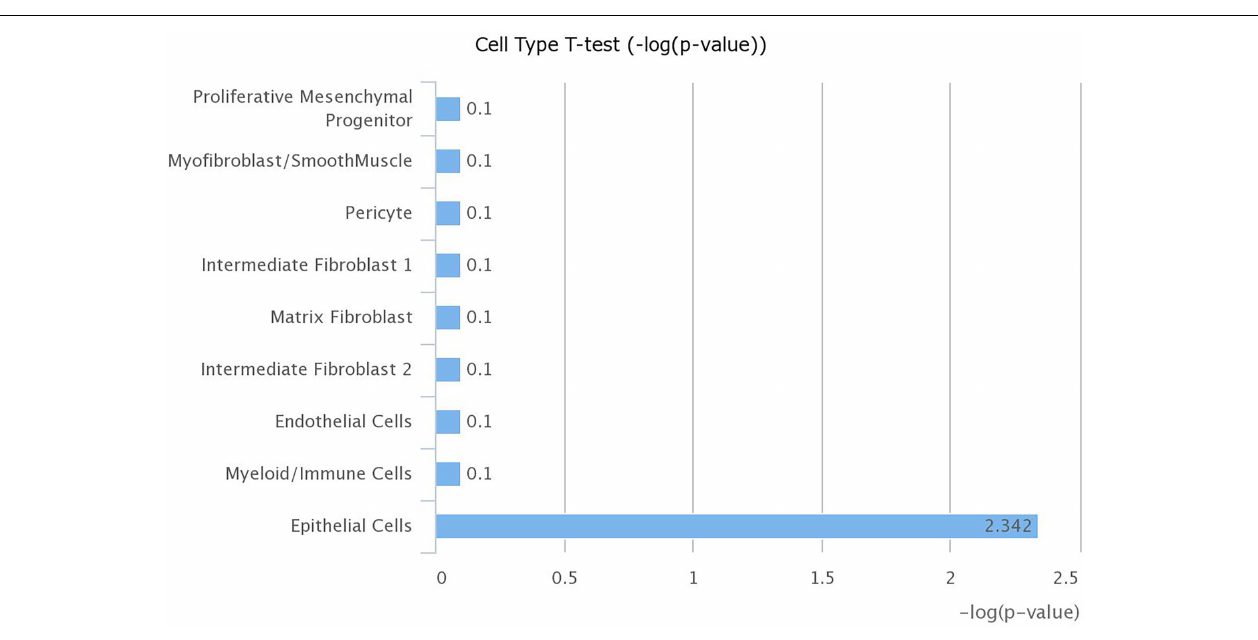
individuals after weight loss compared to baseline ( Figure 8